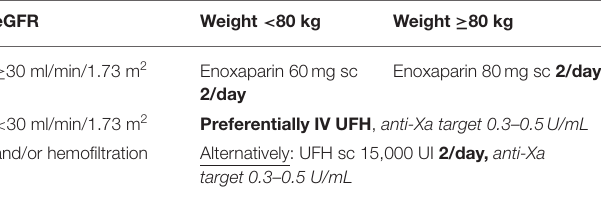
TABLE 2 | Weight and GFR adapted therapeutic-intensity